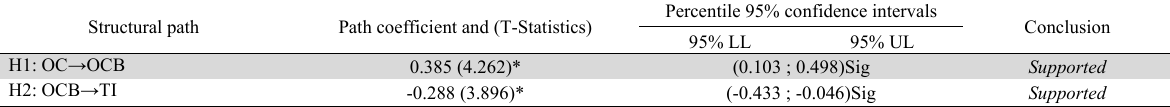
Structural model